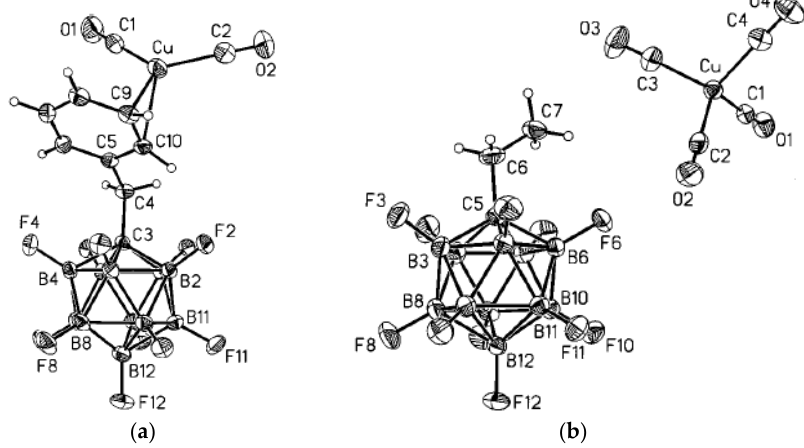
Figure 81. X-ray structures of complexes (CO) 2 Cu[1-Bn-1-CB 11 F 11 ] ( a ) and [Cu(CO) 4 ][1-Et-1-CB 11 F 11 ] ( b ). Reprinted with permission from reference [103]. Copyright © (1999) American Chemical Society.